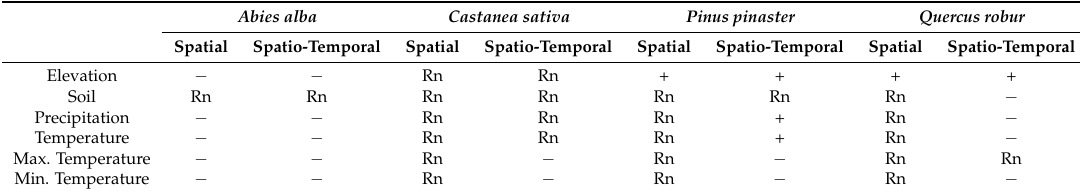
Table 2. Posterior estimates summary. Comparison between variables and presence of different species in spatial and spatio-temporal models (+) represents a positive relationship, ( − ) a negative relationship, and (Rn) not a clear relationship. Abies alba Castanea sativa